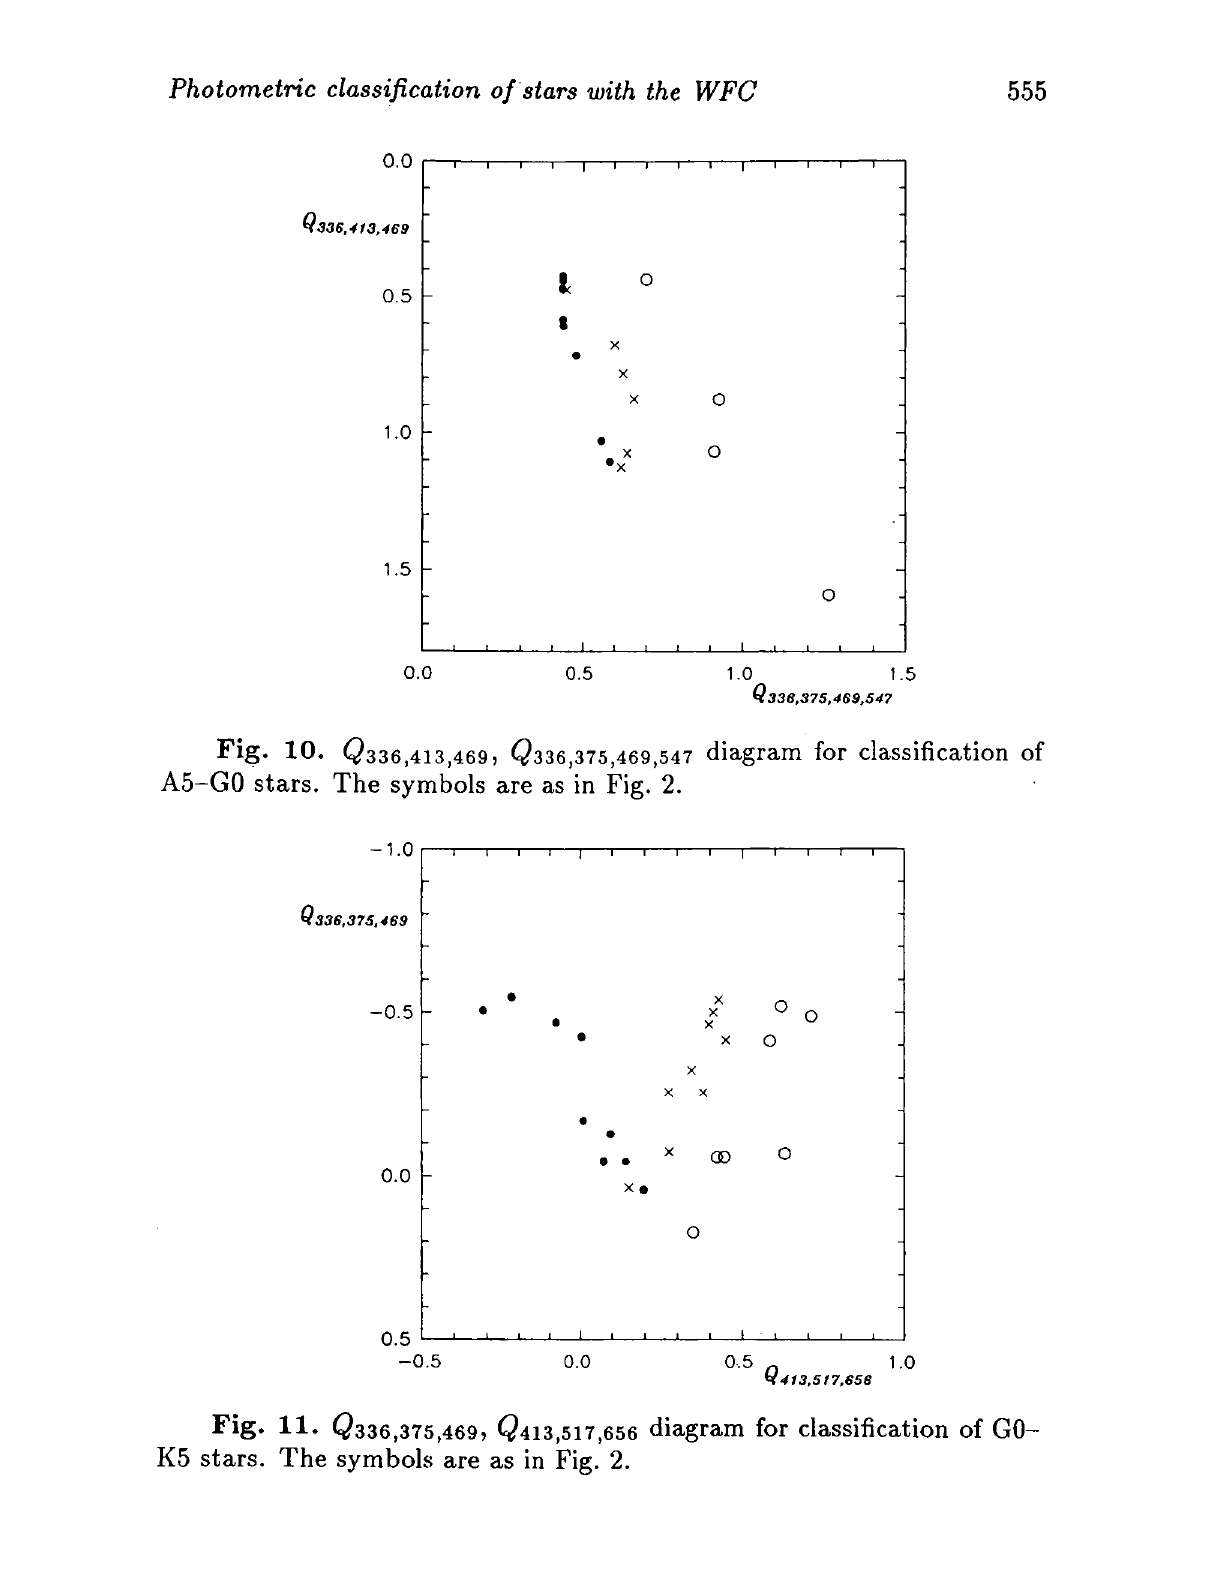
Fig. 11. Q 336,375,469, Q413,517,656 diagram for classification of G0- K5 stars. The symbols are as in Fig.